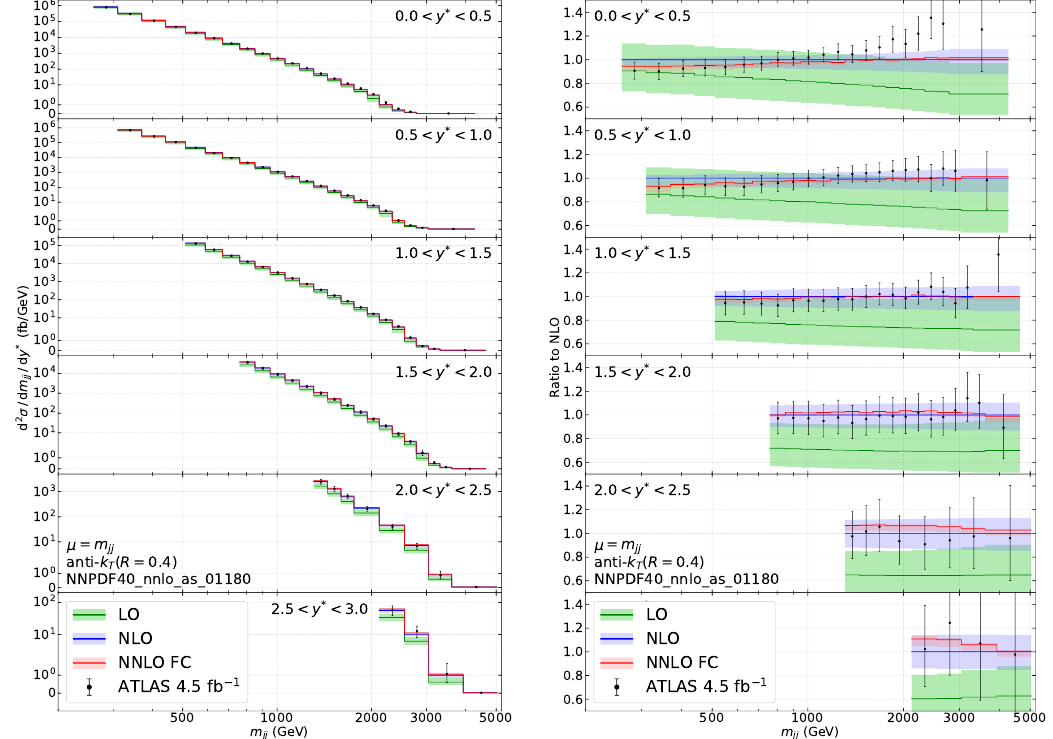
Figure 9 . The doubly differential dijet cross section as function of the invariant jet mass m jj for all the considered absolute rapidity difference y ∗ slices with R = 0 . 4 anti- k T jets compared to the ATLAS 7 TeV data [88] in absolute terms (left) and normalized to the NLO prediction